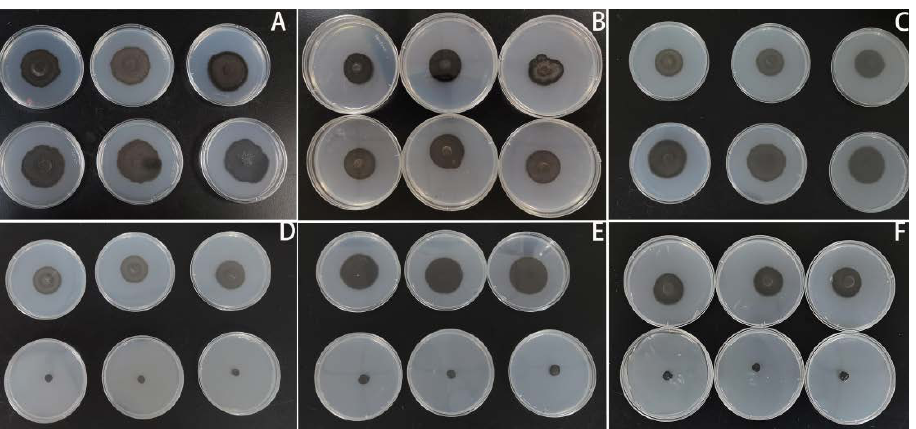
Figure 1. The mycelial growth areas of different isolates of Cenococcum geophilum under different temperatures after 30 days culture. In each image, the first row shows the growth area of the isolate cultured at 25 °C and the second row at 30 °C. ( A ) ACg07, ( B ) ChCg28, ( C ) ChCg100, ( D ) ChCg01, ( E ) JaCg144, ( F ) JaCg202.